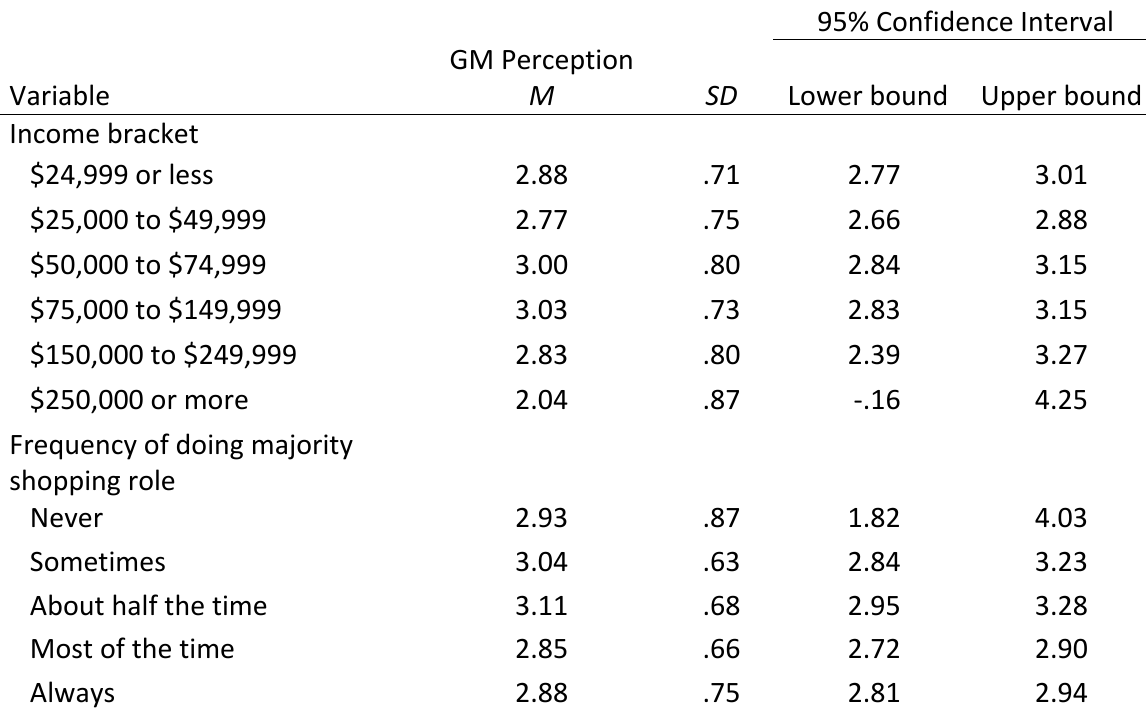
Descriptive Results of GM Perceptions by Income Bracket s and Shopper Responsibility